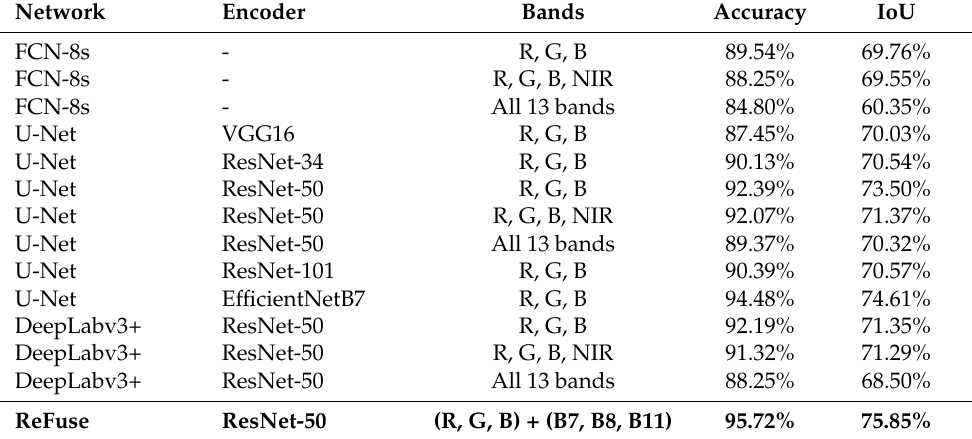
Table 2. Results obtained by the proposed approach (last row) and the considered competitors for the imperviousness map extraction. For the proposed approach (ReFuse), the use of brackets under the “bands” column highlights the ability of the proposed approach to use different bands type, without the need for